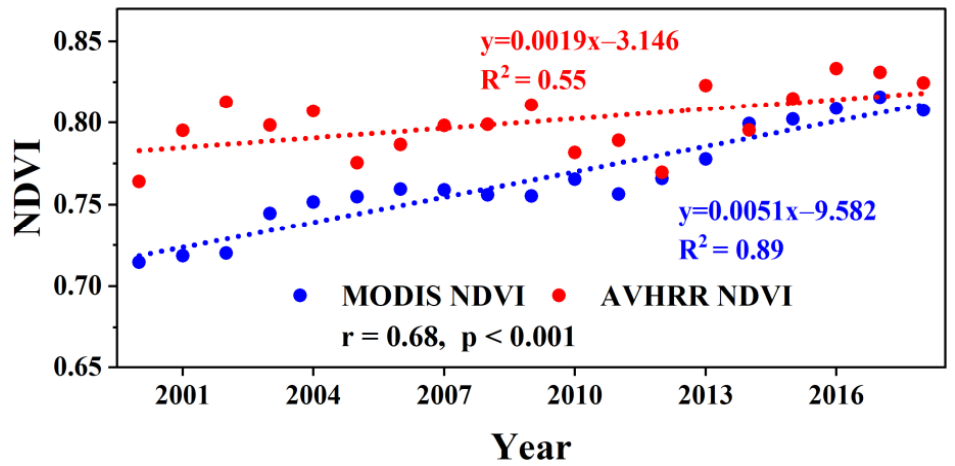
Figure 2. The intercomparison of the accuracy and consistency between the AVHRR and MODIS NDVI datasets during the overlapped period.